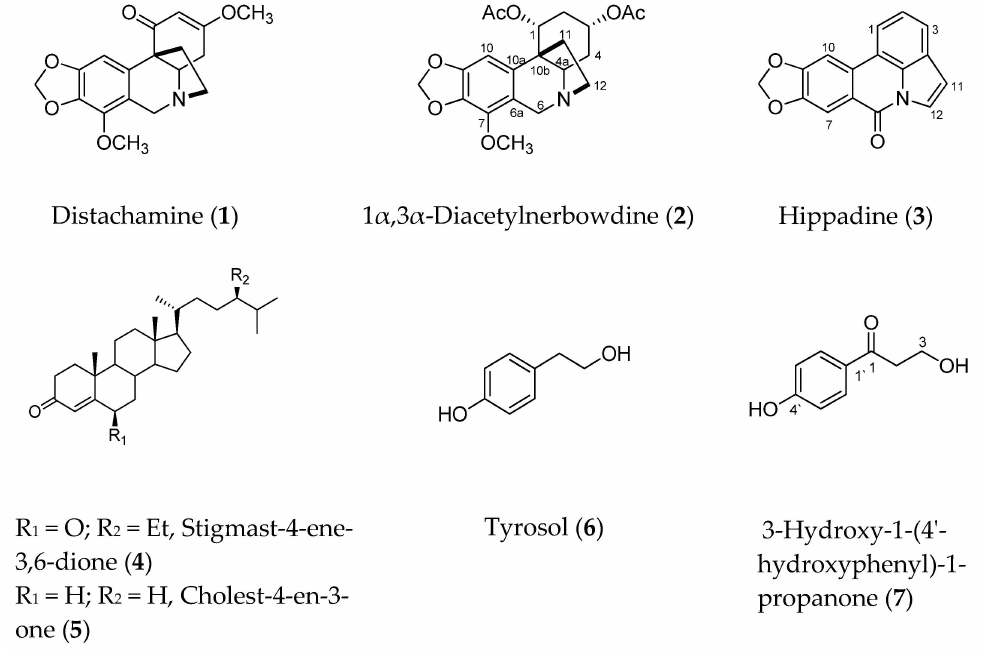
Figure 1. Chemical structures of compounds 1 – 7 isolated from B. haementhoids